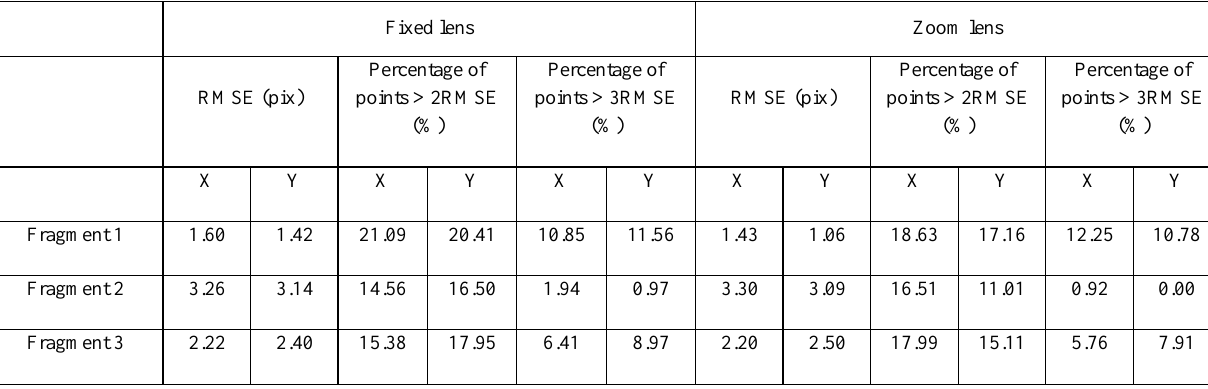
Table 5. The error values and the percentage of points greater than 2RMSE and 3RMSE for calibration with the ComputerVision method.